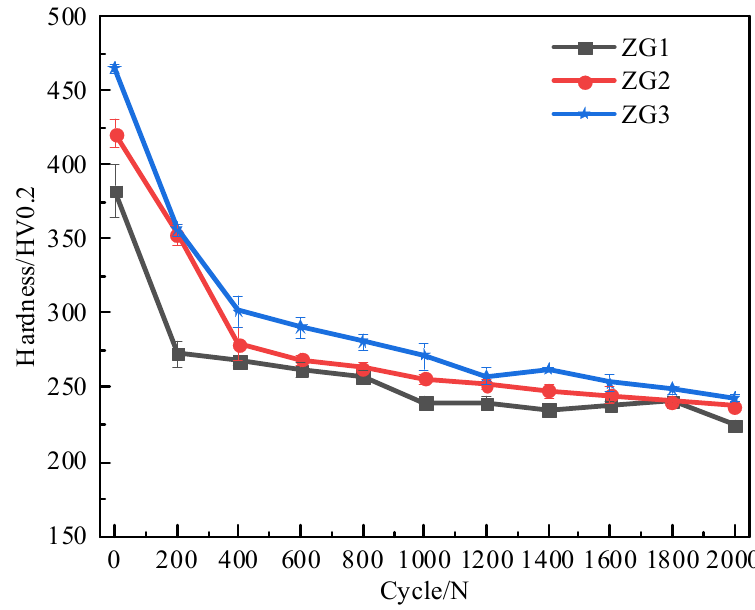
Figure 5. Material hardness variation with the number of thermal